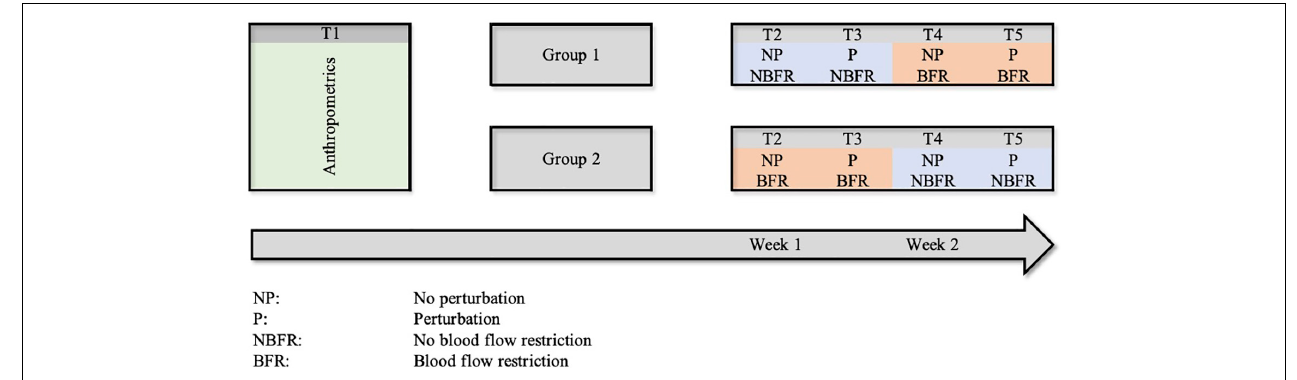
FIGURE 1 | Within subject design of the